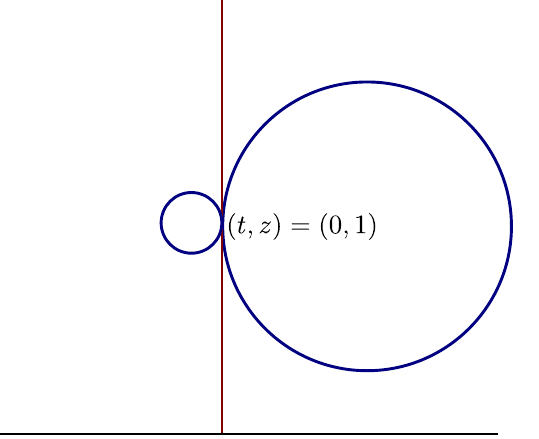
Figure 12 . The geodesic length can go to zero when one of the distances u 12 becomes small. This dictates the maximal value of the two-point function G (cid:24) 1 =(cid:13) 2 m . In this situation, invariance under inversion (cid:12)xes y = 1. Thus we can treat y = 1 as an ultraviolet cuto(cid:11). function, as before, is G = (cid:13) (cid:0) 2(cid:1) . There is no analytical solution, however the equations can be solved numerically with good